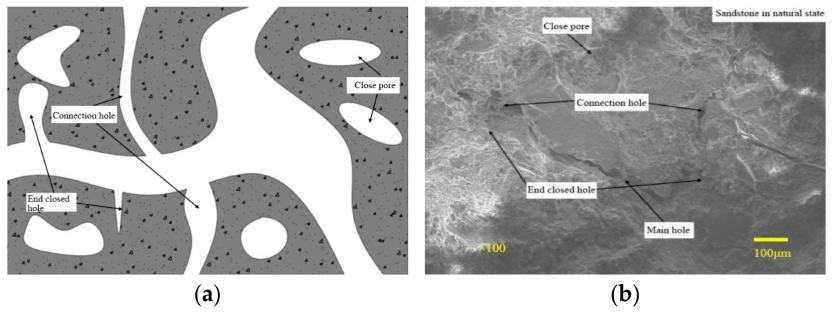
Figure 11. Pore structure in sandstone. ( a ) concept map; ( b ) physical